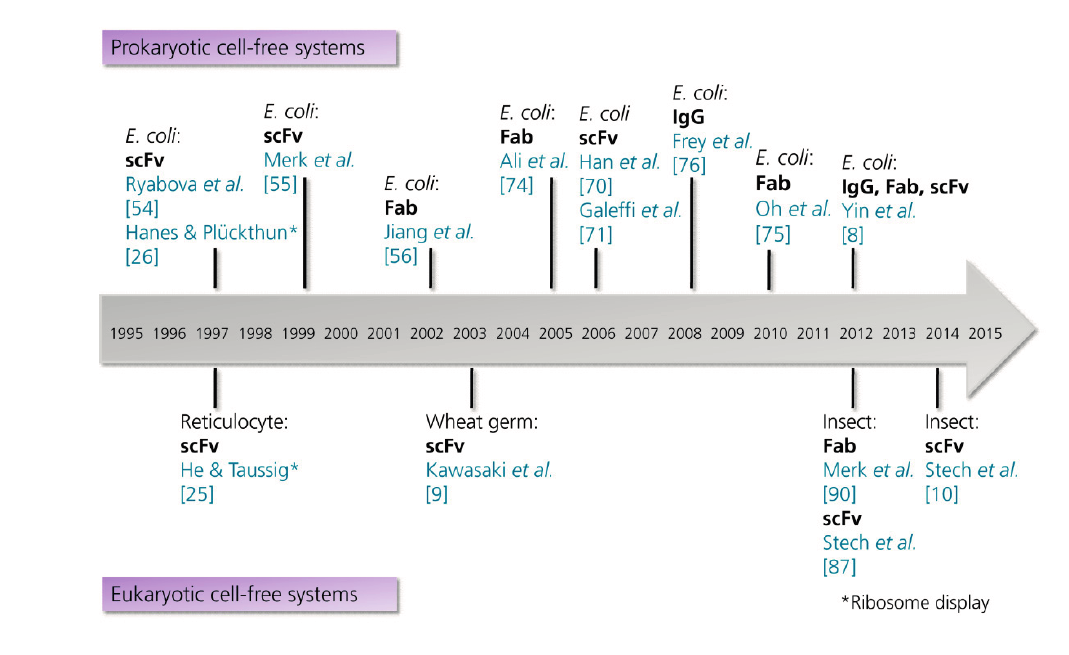
Figure 3. Timeline showing the milestones in the cell-free synthesis of antibody fragments and antibodies. Abbreviations: E. coli , Escherichia coli ; Fab, antigen binding fragment; IgG, immunoglobulin G; scFv, single-chain variable fragment. References are listed in brackets. (This list is not intended to be exhaustive. Examples for the synthesis of antibody-protein and antibody-toxin fusions are